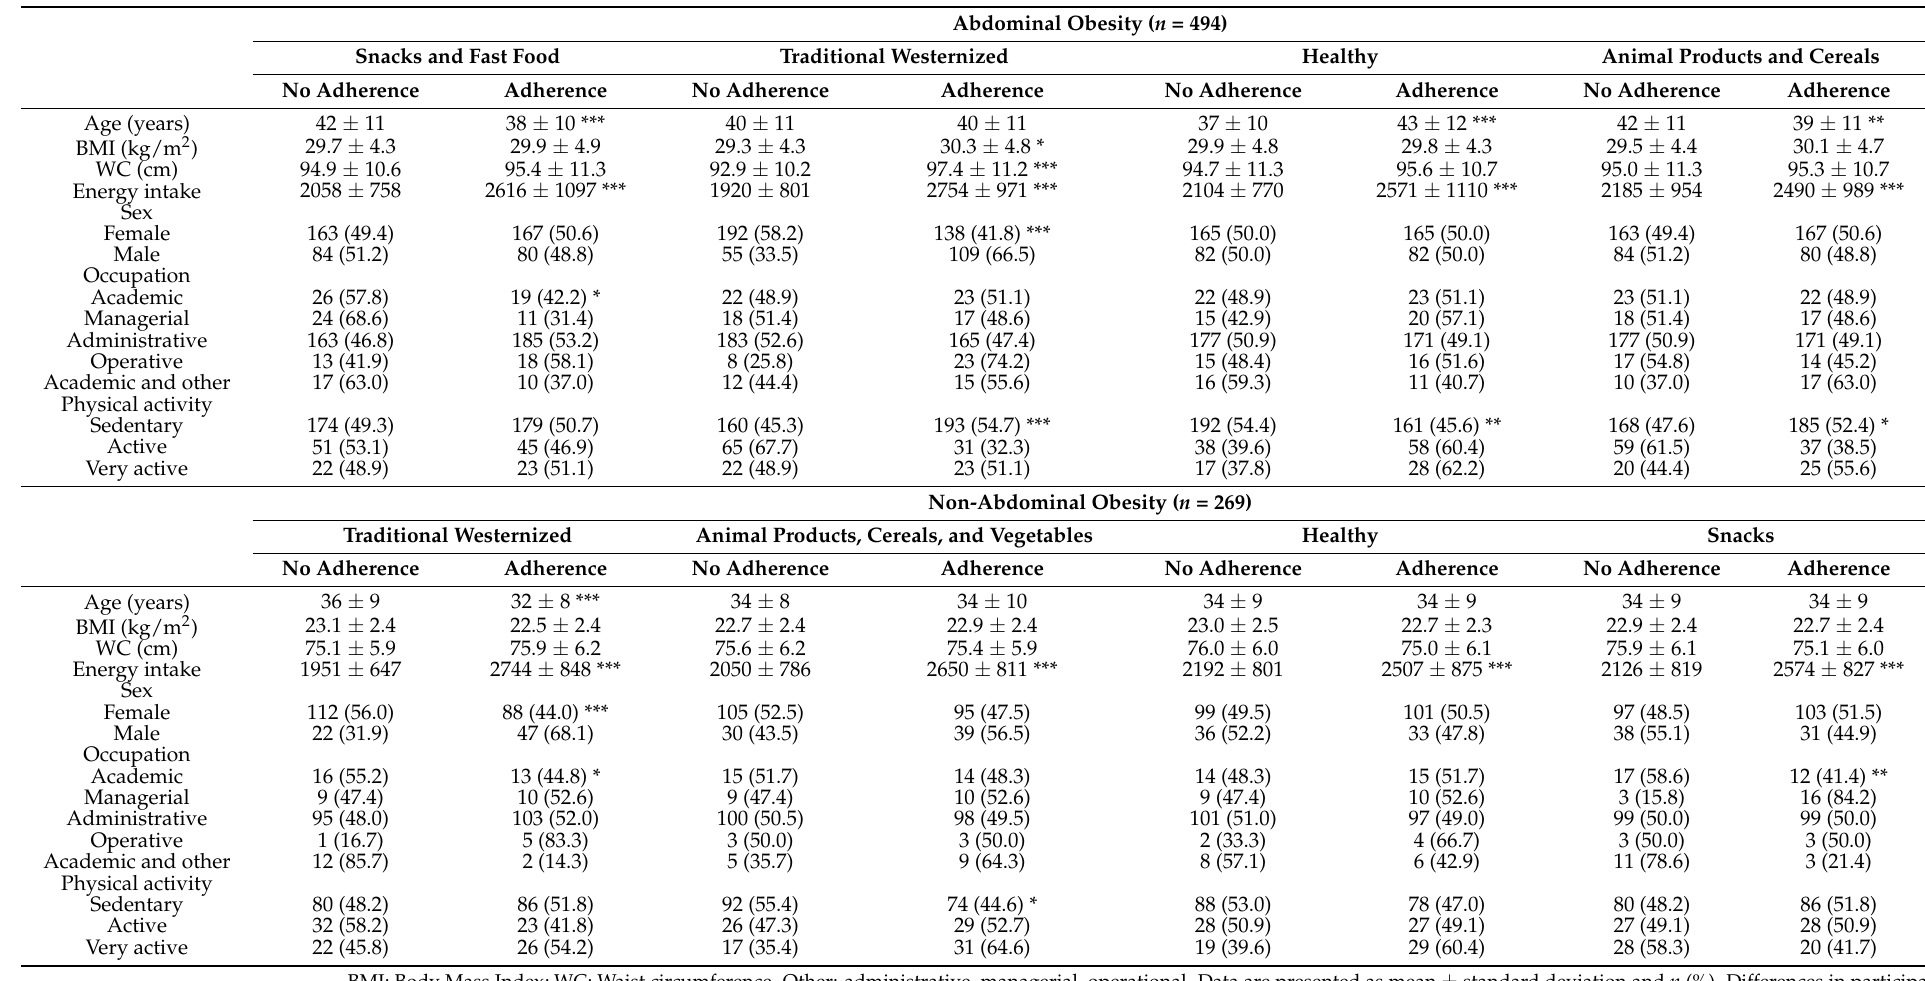
Table 3. Participant characteristics between subjects who adhere or do not adhere to each dietary pattern in participants with or without obesity. Abdominal Obesity ( n = 494) Snacks and Fast Food Traditional Westernized Healthy Animal Products and